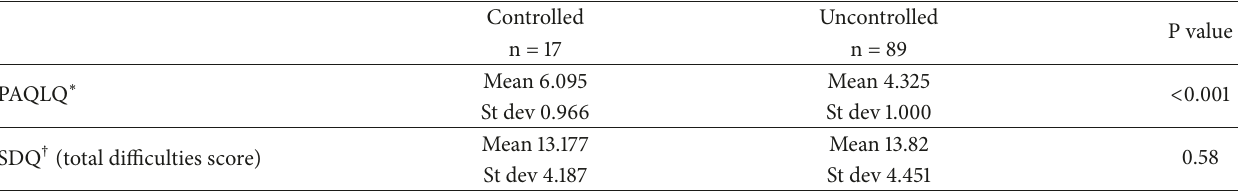
Table 2: The scores of pediatric asthma quality of life questionnaire and the strengths and difficulties questionnaire in relation to asthma control status.